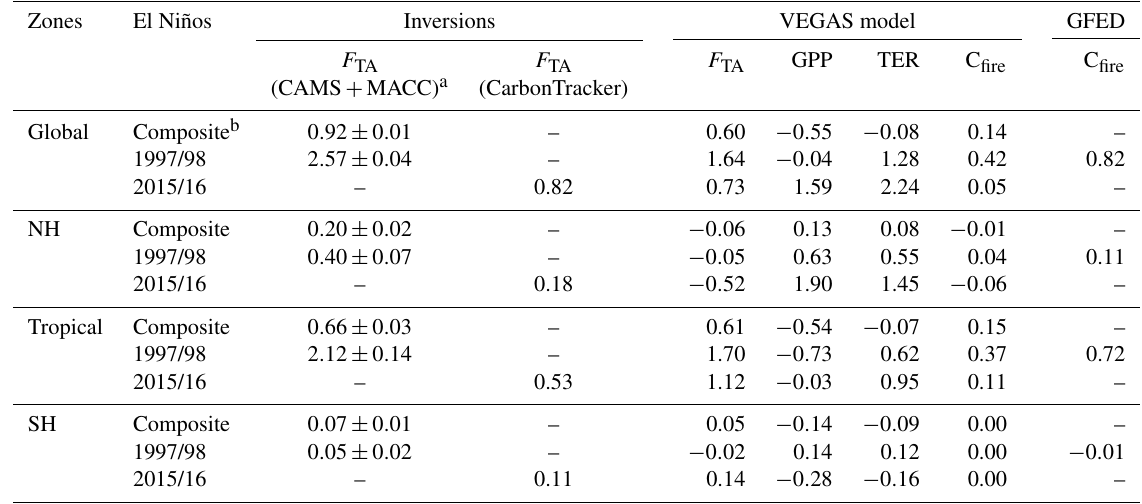
a The mean value of the CAMS and MACC inversion results with the uncertainty of their SD. b Composite analyses exclude the 1982/83, 1991/92, and 2015/16 El Niño events, because the former two cases were disturbed by the El Chichón and Pinatubo eruptions, and the latter is not covered by the inversion